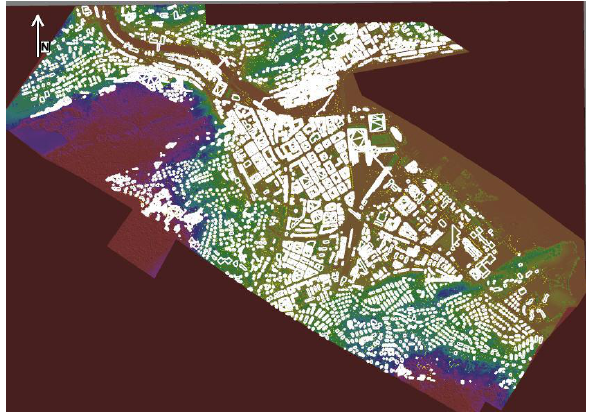
Figure 13. TSR covers 12.2 square kilometers in Luzern, Switzerland (data courtesy of Leica Geosystems)